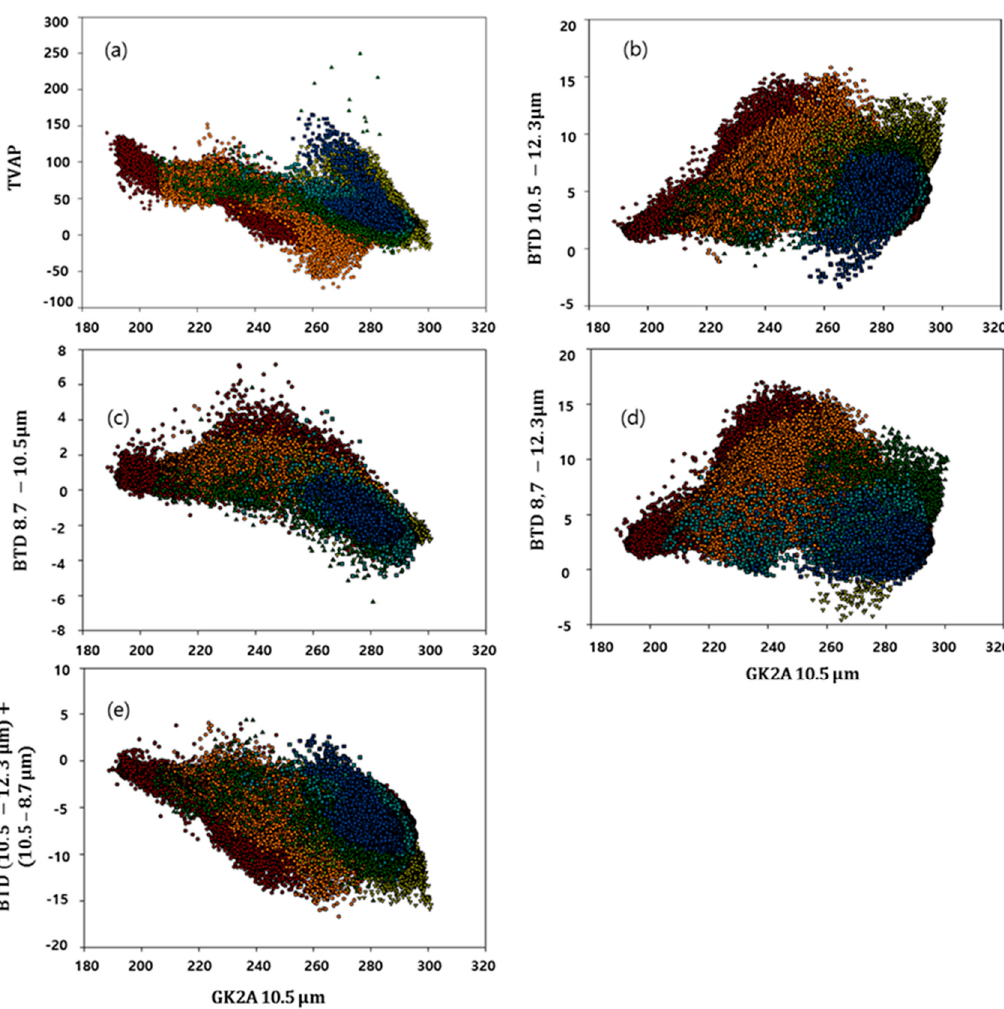
Figure 2. Brightness temperature (BT) versus BT difference (BTD) at 10.5 µ m. ( a ) Three-band VA product (TVAP), ( b ) 10.5–12.3 µ m ( c ) 8.7–10.5 µ m ( d ) 8.7–12.3 µ m ( e ) Ash RGB threshold of GK-2A/AMI for the measurements of the Taal (red, January 12), Merapi (yellow, March 2), Merapi (green, March 27), Krakatau (sky blue, April 10), Semeru (orange, May 16), and Nishinoshima (blue, July 31) eruptions.